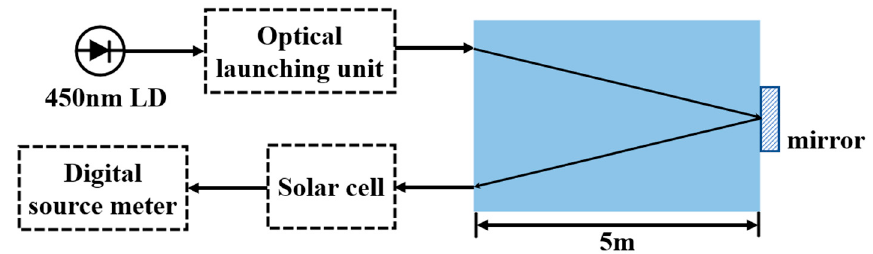
Figure 2. General architecture of the testbed.